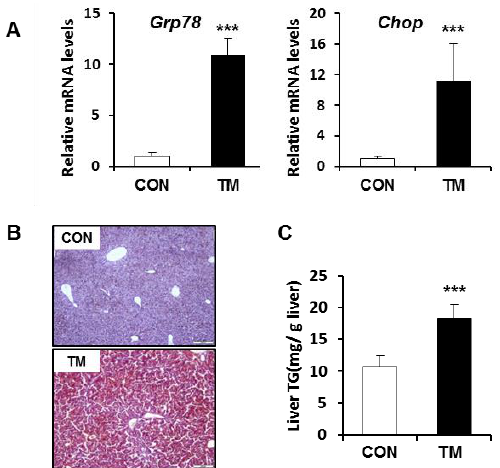
Figure 1. Endoplasmic reticulum (ER) stress-mediated lipid accumulation in the liver of tunicamycin (TM)-treated mice. ( A ) mRNA levels of glucose-regulated protein 78 (Grp78) and CCAAT/enhancer-binding protein homologous protein (CHOP), and ( B ) Oil Red O staining in the liver (20× magnification). ( C ) Levels of triglyceride in the homogenates of the liver. Each value represents the mean ± SD. *** Statistically significant difference between control (white) and TM-treated mice (black) at p < 0.001 (Student’s t -test).